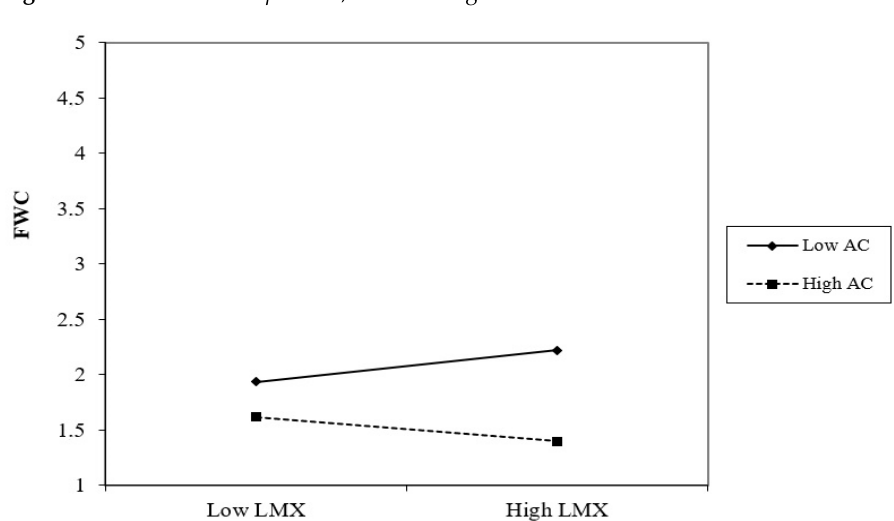
Figure 2. Moderation effect of AC on the relationship between LMX and FWC.